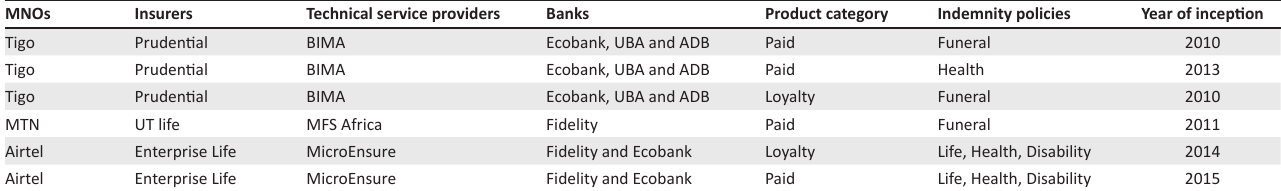
TABLE 2: M-insurance products offerings and service providers in Ghana.